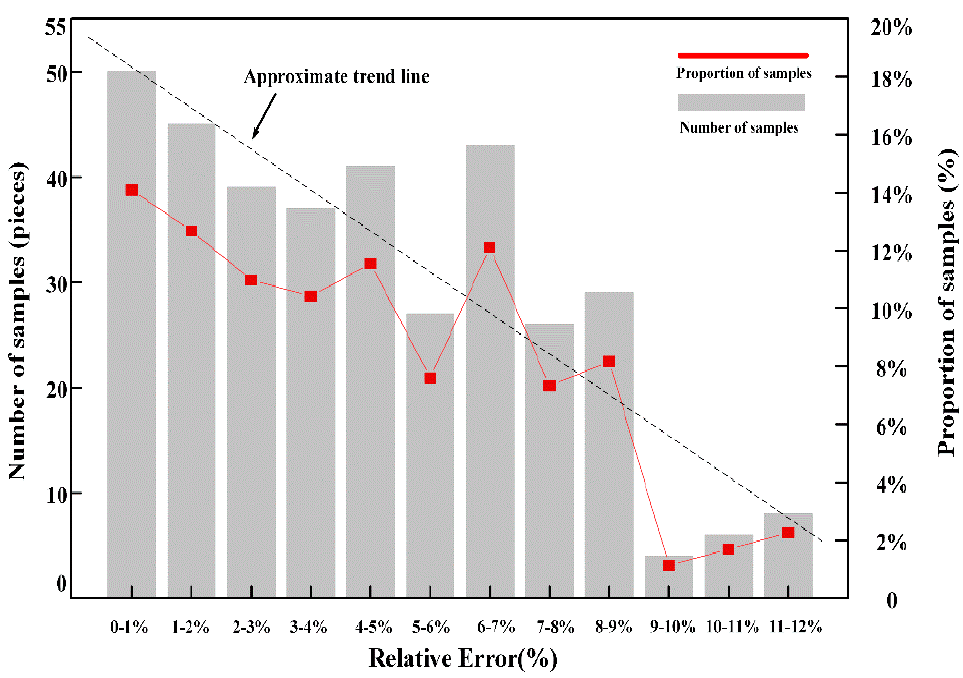
Figure 15. Relative error number distribution when separating mixed data. Figure 18. Relative error number distribution when separating mixed data.